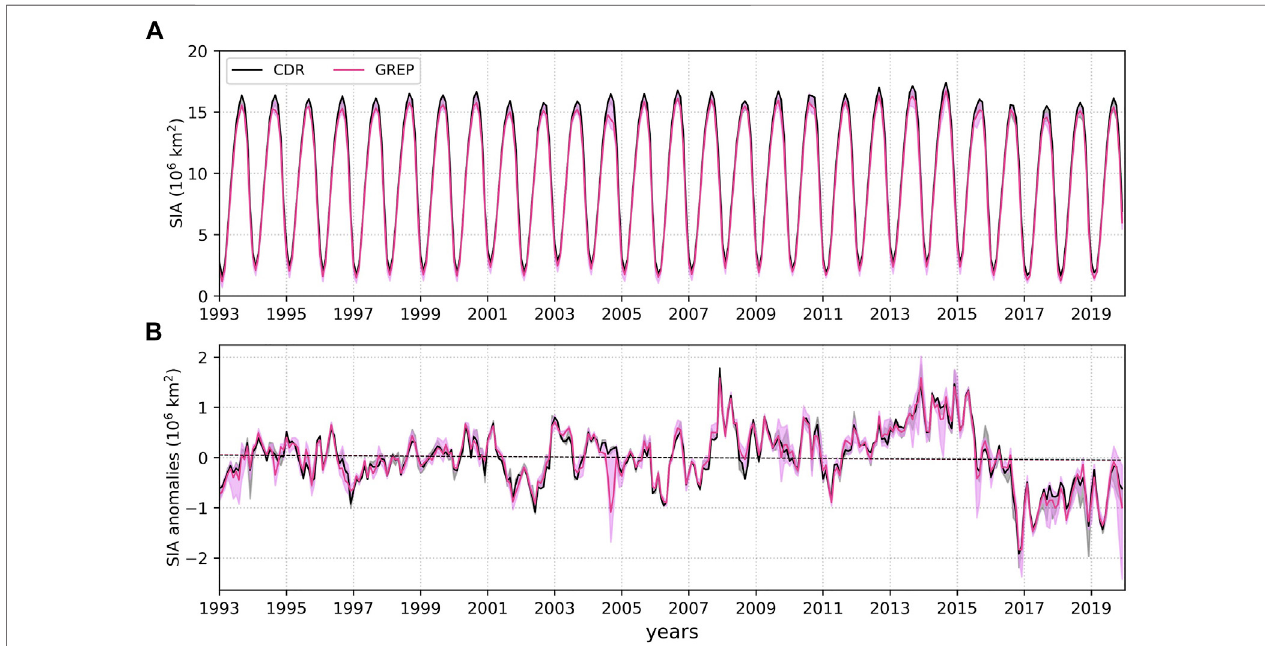
FIGURE 2 | Time series of (A) monthly averages and (B) monthly anomalies of Antarctic sea ice area in GREP (magenta) and CDR (black) from January 1993 to December 2019, for GREP (magenta) and CDR (black). Pink (gray) shading denotes the envelope of GREP members (CDR, OSISAF, Ifremer CERSAT satellite records).